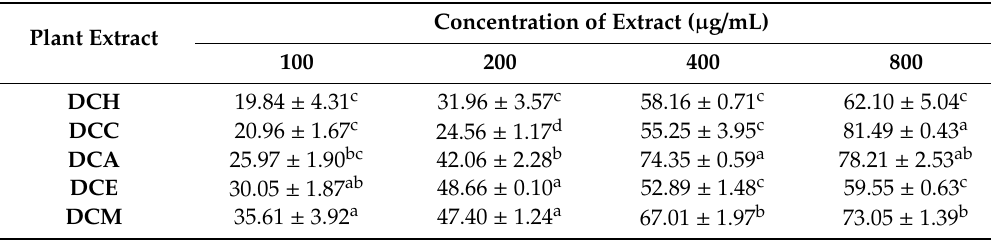
Table 4. Percentage of HeLa cell growth inhibition by the extracts at di ff erent concentrations. Plant Extract